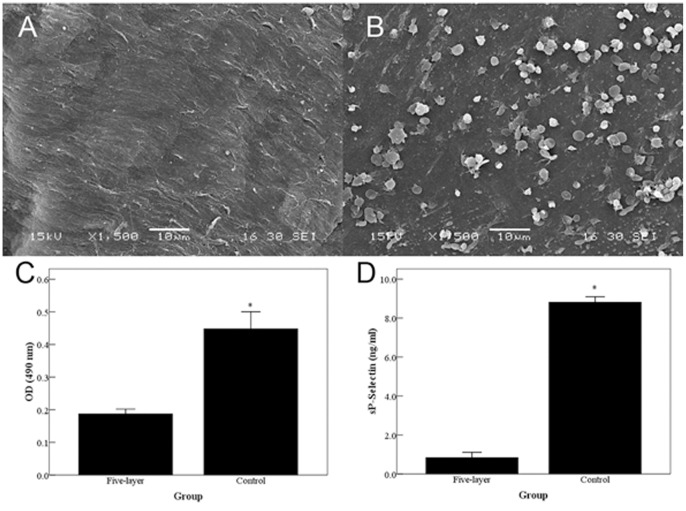
SEM images of human platelet-rich plasma (PRP) incubated with DPAV.There are many adhered platelets on UnDPAV (B) as compared to five-layer groups (A). Platelets on UnDPAV demonstrated aggregate and changed morphology. The number of adhered platelets on valves as was determined by quantification of LDH activity (C). Platelet activation is measured by sP-selectin levels (D). * Corresponds to a p<0.001 of five-layer PEM-DPAV in comparison to UnDPAV. (A, B) scale bars: 10 µm.